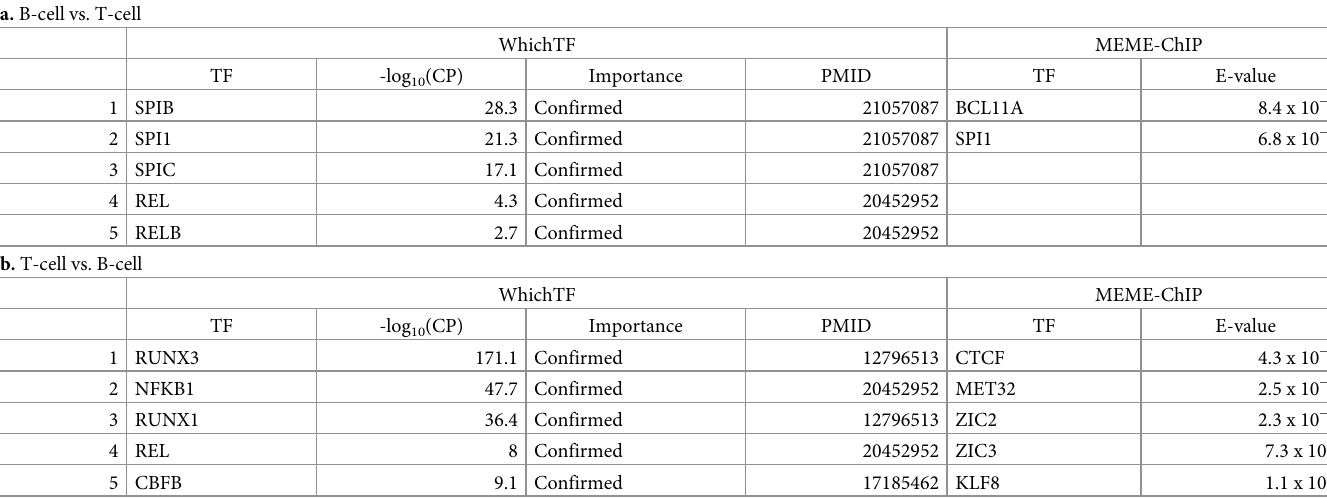
The top 5 TFs identified for (a) B-cells relative to T-cells (B-cell minus T-cell) and (b) vice versa (T-cell minus B-cell) are shown with the corresponding statistical significance, negative log 10 conditional probabilities (-log 10 (CP)). The results from a MEME-ChIP differential analysis are shown for comparison. The E-value is